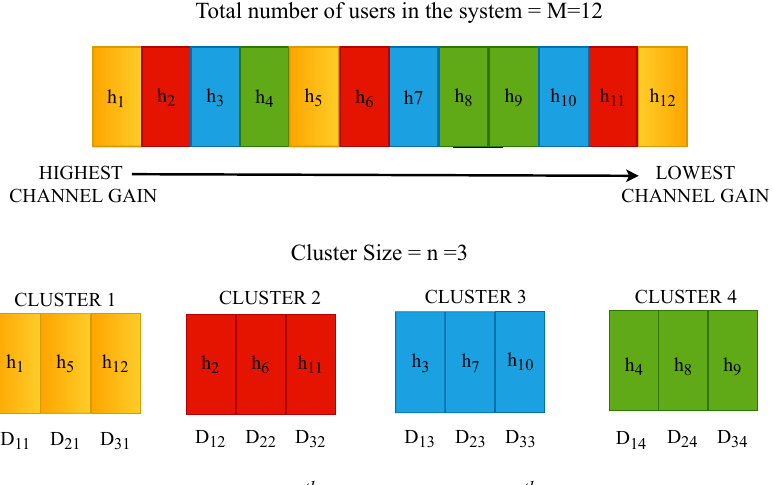
Figure 4. Clustering mechanism used in the proposed downlink TDMA-RIS-NOMA.